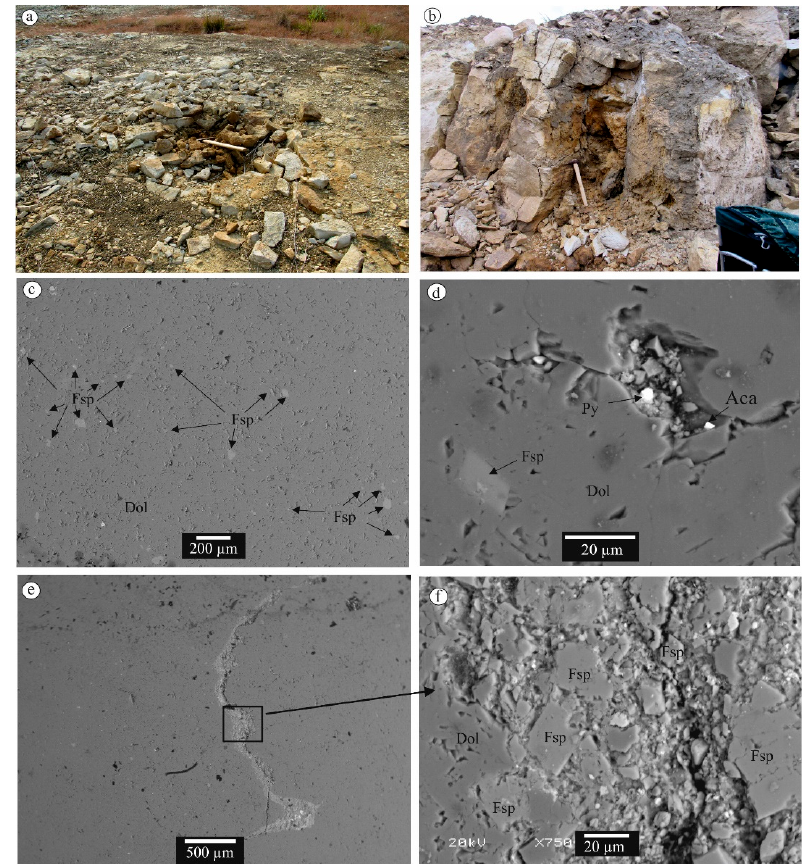
Figure 11. Apocarbonate quartz-potassium feldspar metasomatites: ( a ) the cataclase zone in bedrock of the worked placer, where hydrothermalites are developed (Kurung Yuryakh site); ( b ) weathered hydrothermal-metasomatic formations in the wall of the artificial channel at the sources of the Billyakh river; ( c , d ) disseminated potassium feldspar mineralization (BSE mode); ( e , f ) potassium feldspar in veinlets of variable quartz-iron-aluminosilicate composition (BSE mode). Fsp—potassium feldspar; Dol—dolomite; Py—pyrite; Aca—acanthite.